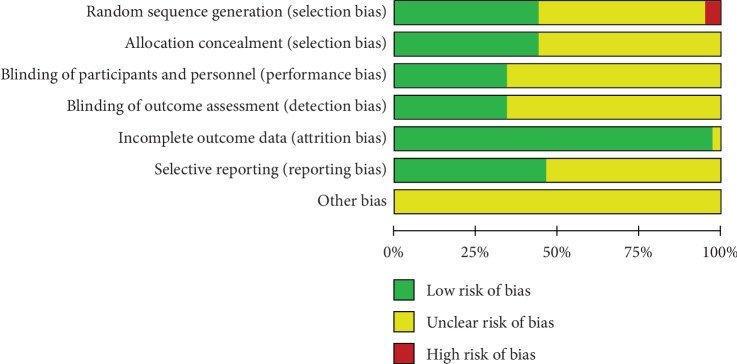
Risk of bias graph.